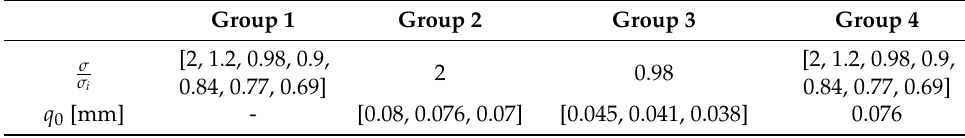
Table 3. Relative cavitation number and modal